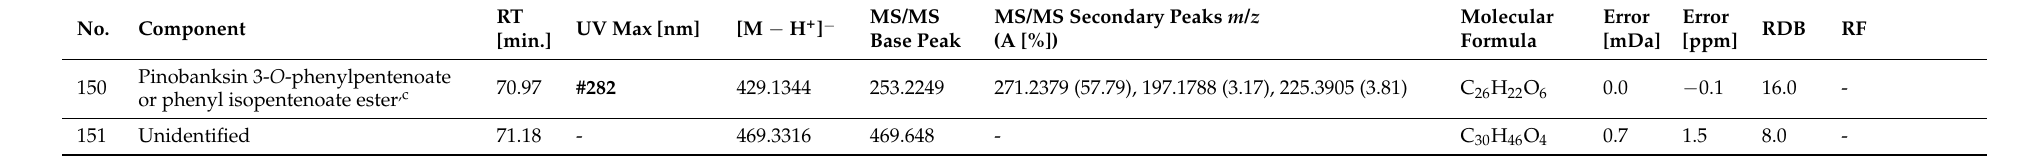
Table legend: No—number; UV max [nm]—maximum of UV absorption, higher maximum is bolded; RBD—ring and double bond equivalents; - component did not produce ion or did not have UV spectrum (or too low concentration); #—UV spectrum is weak due to low concentration and its maximum is unclear; a component identified by comparison with standard;